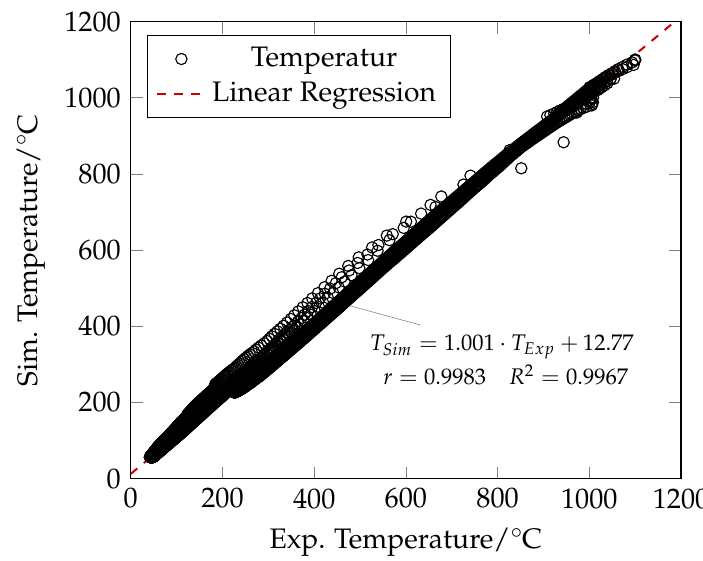
Figure 14. Cooling rate ˙ T calculated by FE simulation as a function of the distance (along the X axis equal to 12 mm from Y=0 mm to Y=100 mm)